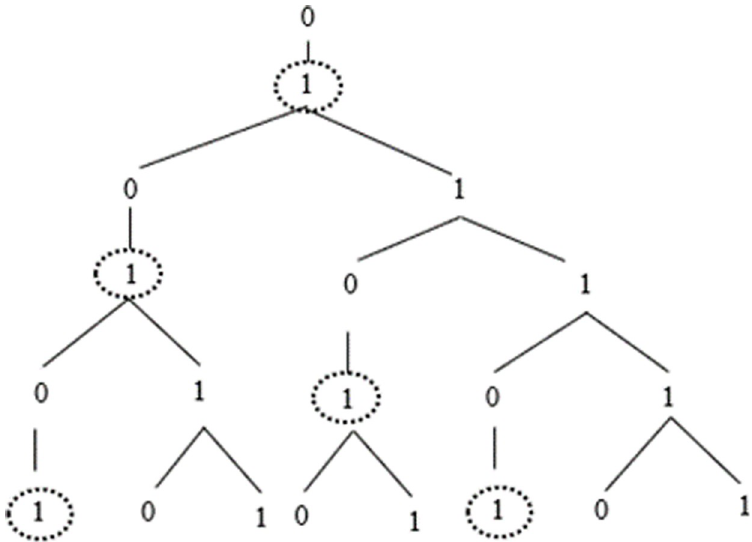
Fig 5. Graphical representation of k -points (circled with dotted line) in a